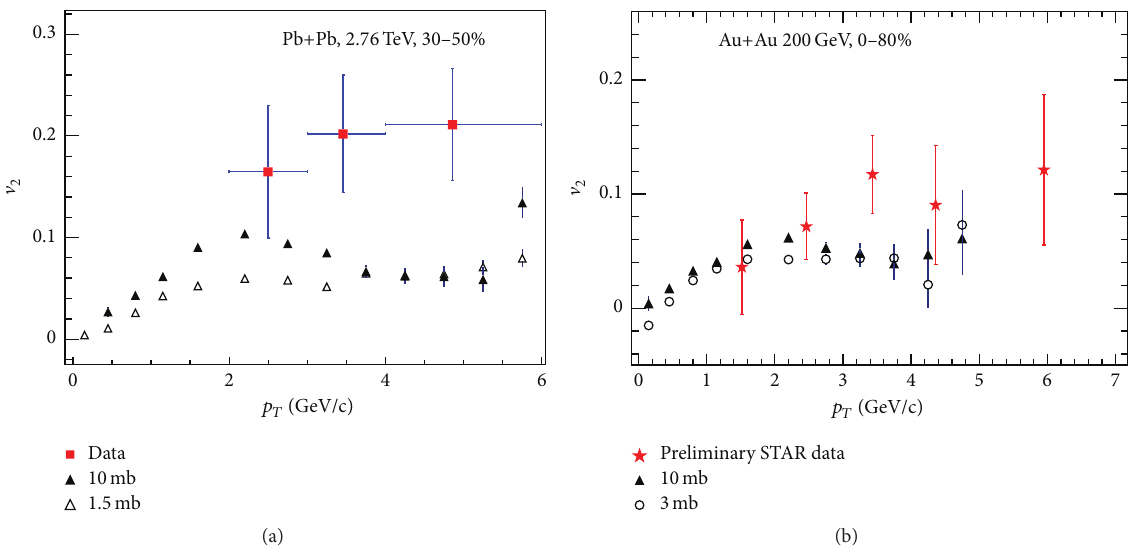
Figure 9: (a) Elliptic flow of 𝐷 0 meson at mid-rapidity in Pb+Pb collision at √𝑠 NN = 2.76 TeV for 30–50% centrality and model predictions from AMPT. Only statistical error is shown for ALICE data. (b) Elliptic flow of 𝐷 0 meson at midrapidity in 0–80% min-bias Au+Au collision at √𝑠 NN = 200 GeV and prediction from AMPT. Only statistical error is shown for STAR preliminary